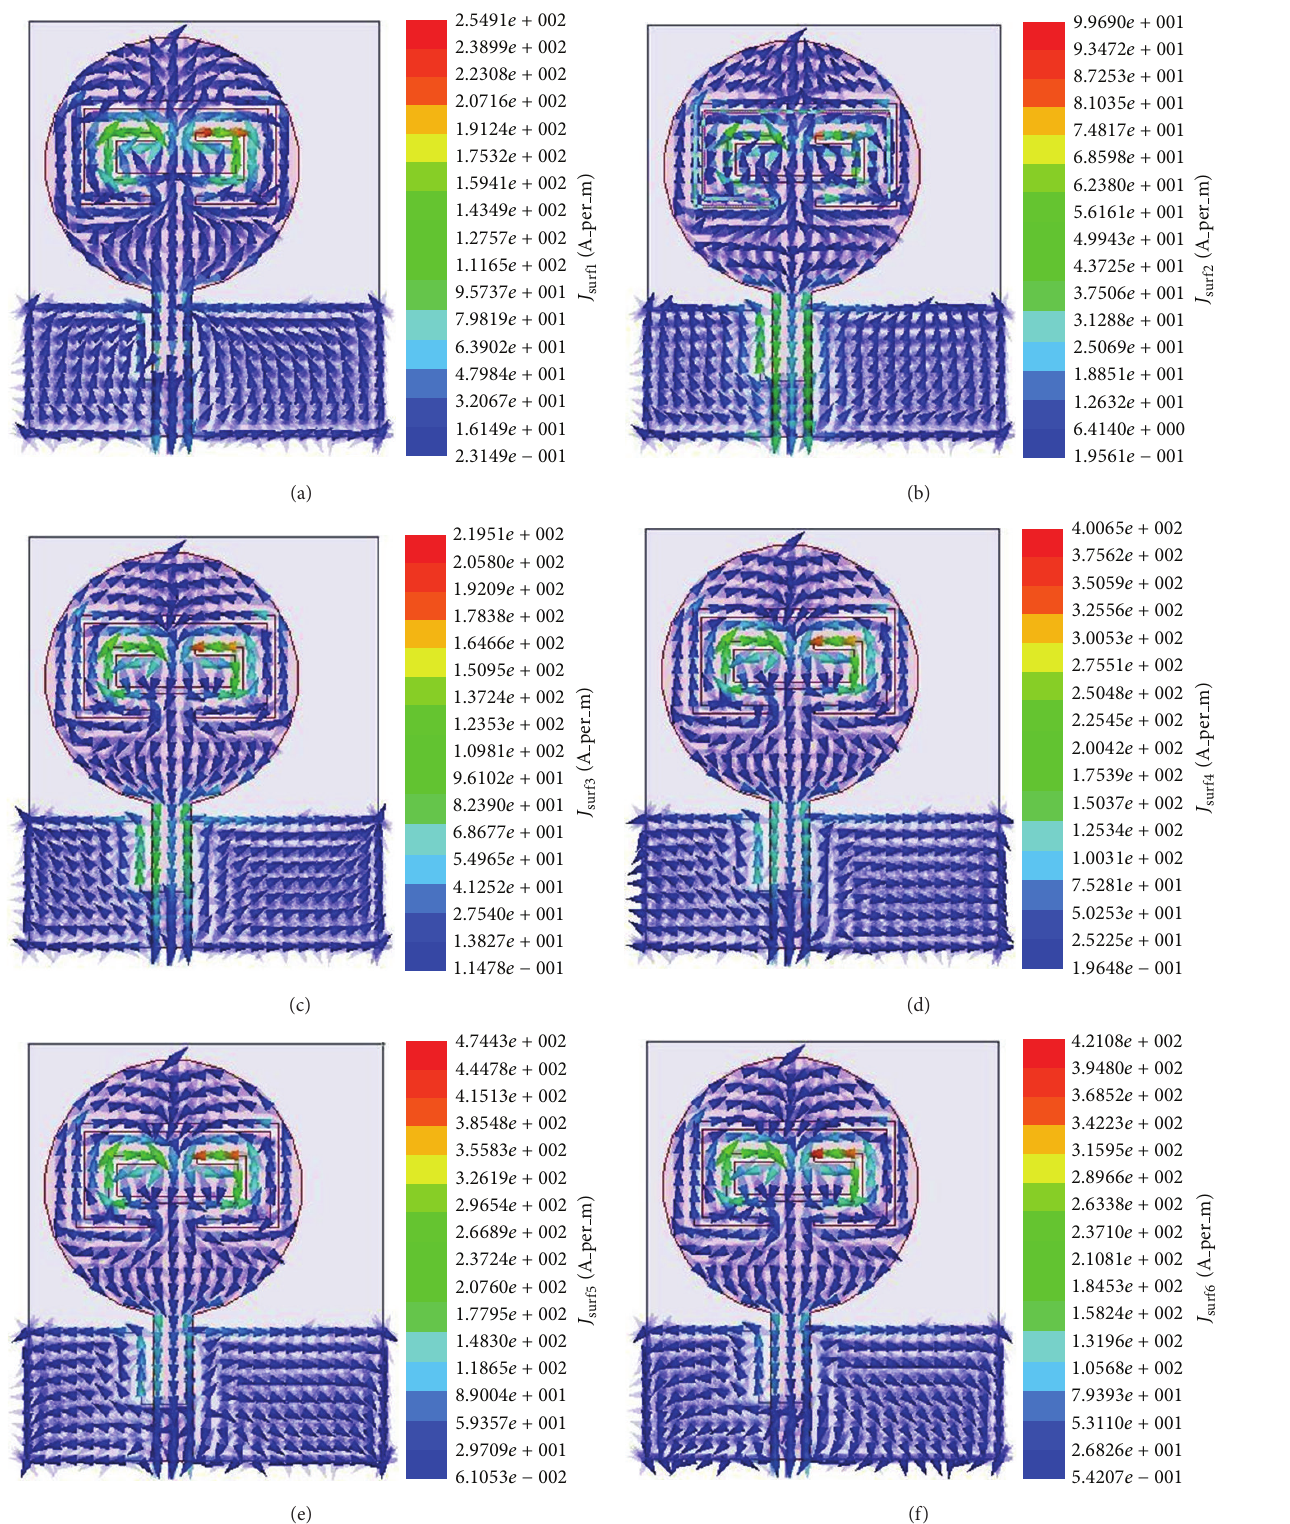
Figure 2: Surface current at 5.5 GHz for different values of the phase angle (a) 0 ∘ , (b) 30 ∘ , (c) 60 ∘ , (d) 90 ∘ , (e) 120 ∘ , and (f) 150 ∘